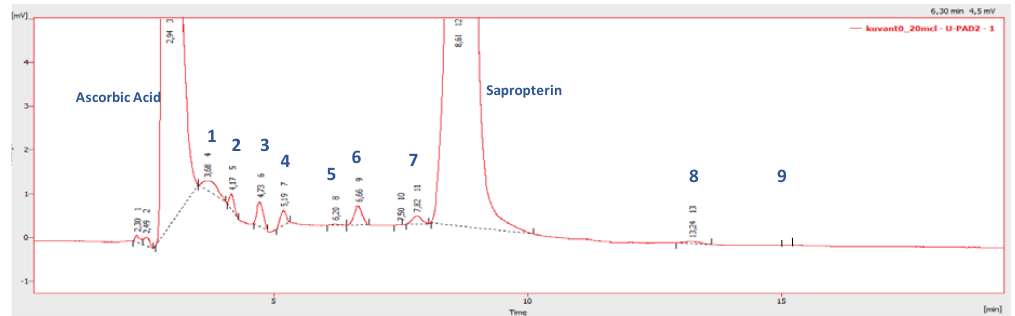
Figure 1. HPLC profile of pulverized Kuvan ® tablet at T = 0 dissolved in 7.0 mL of a 0.2% (w / v) solution of ascorbic acid in water. HPLC-UV ( λ 265 nm) was run in isocratic mode on an ion-exchange Partisil ® column using 0.03 M NaH 2 PO 4 water solution (pH 3.0) as an eluent.